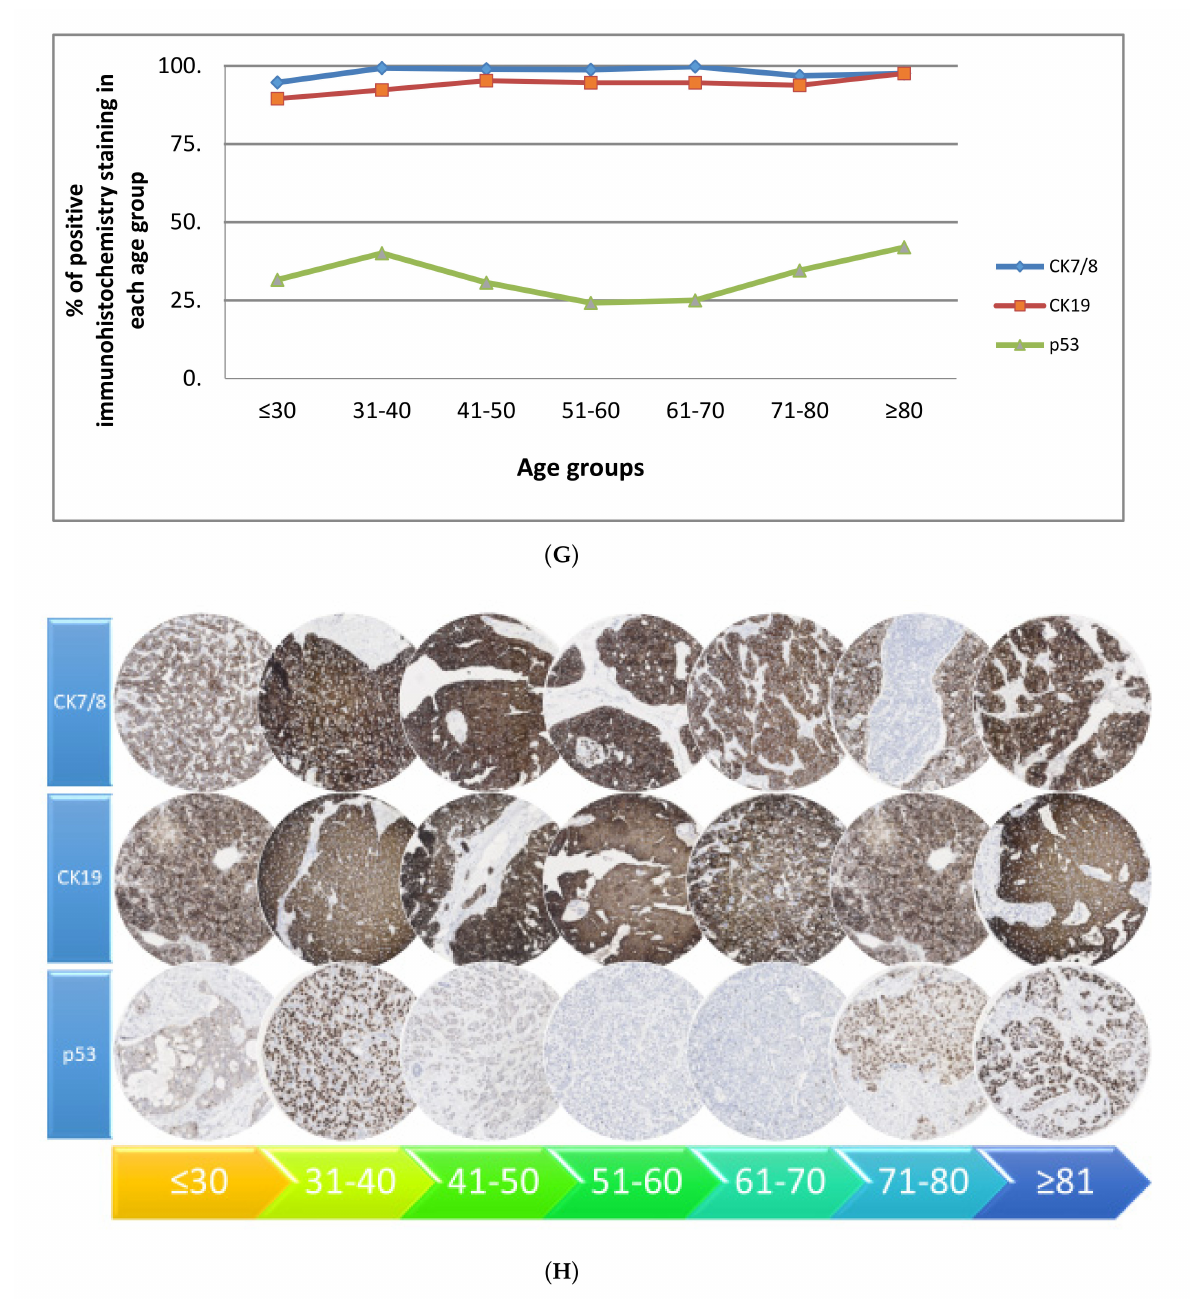
Figure 1. ( A ) Pattern of the expression of biomarkers with age stratification in early operable primary breast cancer treated by surgery—significant rise at 40 years. ( B ) Pattern of the expression of biomarkers with age stratification in early operable primary breast cancer treated by surgery—significant rise at 40 years (at nanozoomer magnification × 20). ( C ) Pattern of the expression of biomarkers with age stratification in early operable primary breast cancer treated by surgery—significant decline at 40 years. ( D ) Pattern of the expression of biomarkers with age stratification in early operable primary breast cancer treated by surgery—significant decline at 40 years (at nanozoomer magnification × 20). ( E ) Pattern of the expression of biomarkers with age stratification in early operable primary breast cancer treated by surgery—significant rise at 70 years. ( F ) Pattern of the expression of biomarkers with age stratification in early operable primary breast cancer treated by surgery—significant rise at 70 years (at nanozoomer magnification × 20). ( G ) Pattern of the expression of biomarkers with age stratification in early operable primary breast cancer treated by surgery—two peaks. ( H ) Pattern of the expression of biomarkers with age stratification in early operable primary breast cancer treated by surgery—two peaks (at nanozoomer magnification ×